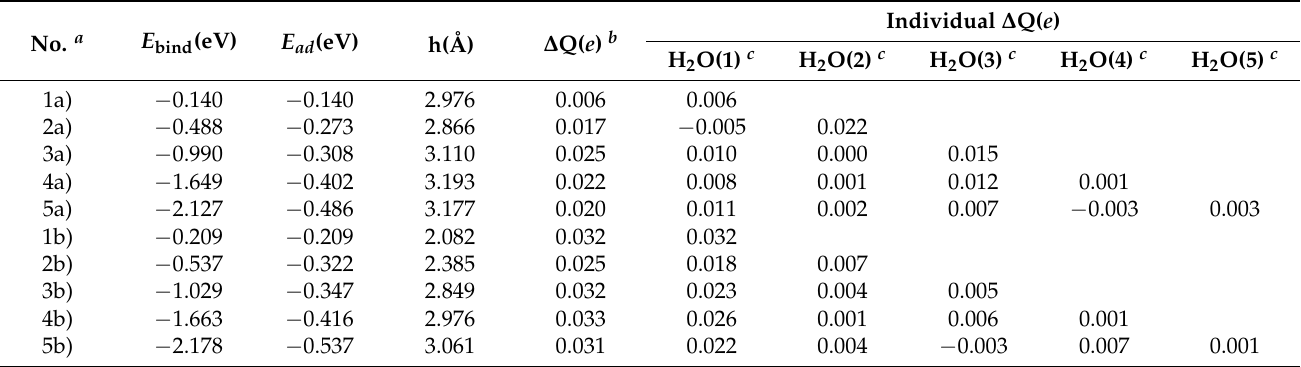
a The numbering notations correspond to the structures presented in Figure 3. b The sign of the charge transfer value indicates the direction. c The numbering notations correspond to the water molecules presented in Figure